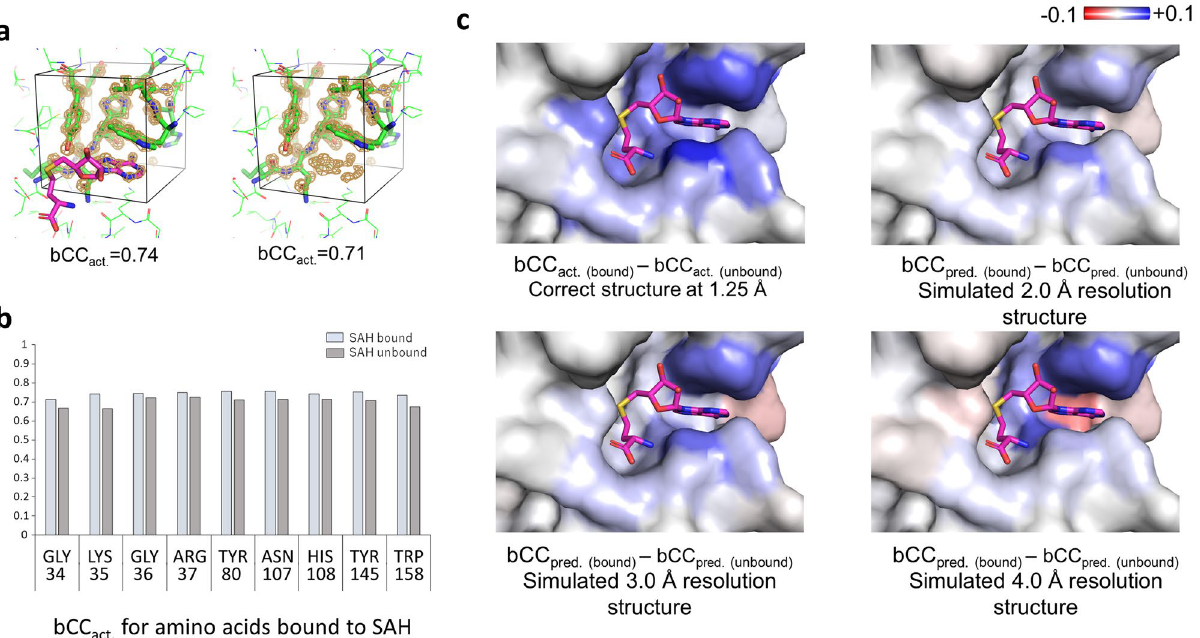
Figure 7. Application of QAEmap for a compound binding. ( a ) Boxes with (left) and without (right) SAH of His108 of SET domain protein methyltransferase (PDB: 3F9X, at 1.25 Å resolution) neighboring a SAH molecule (magenta), which is an input for QAEmap, includes SAH partially. There are a total of nine residues neighboring SAH. ( b ) Values of bCC act. for the nine residues with and without SAH. ( c ) Surface presentation colored by the differences between SAH-bound and SAH-unbound of bCC act. of the correct structure, or bCC pred. of simulated low-resolution structures at resolutions in the range of 2–4 Å. The scores of bCC indicate the binding structure is